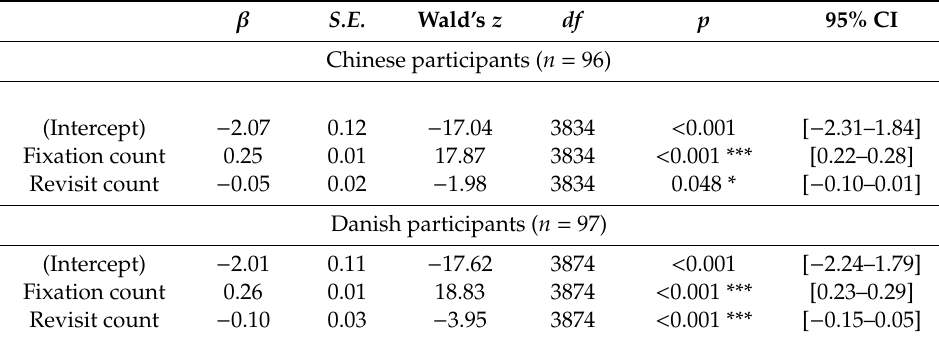
Table 2. Model summary of multiple logistic regression with food choice (chosen = 1; not chosen = 0) as the binomial dependent variable, and fixation count, revisit count, and music condition as the independent